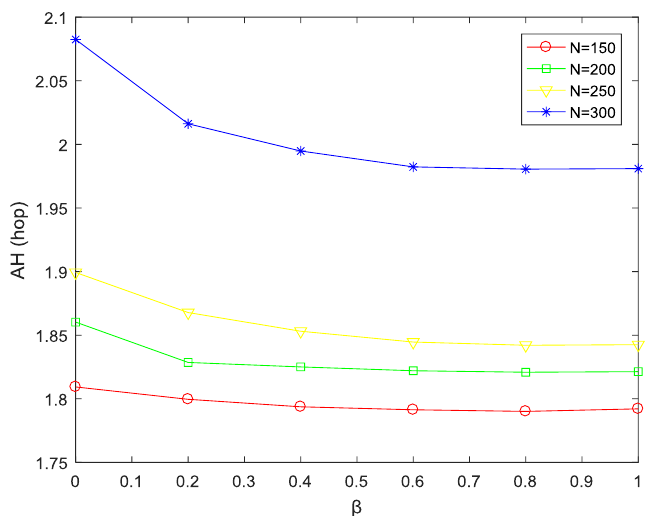
Figure 3. AH varying with β at different network sizes.